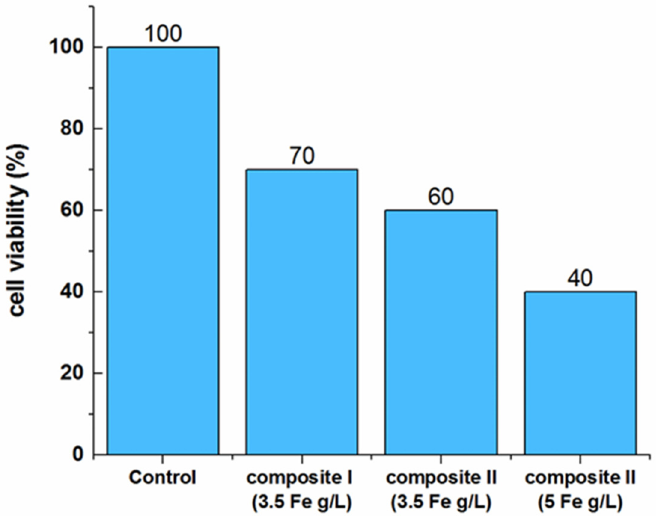
Figure 22. Results of in vitro test for magnetic hyperthermia-treated HepG2 cells. The AFM parameters are f = 525 kHz, H = 9 kA ⋅ m.